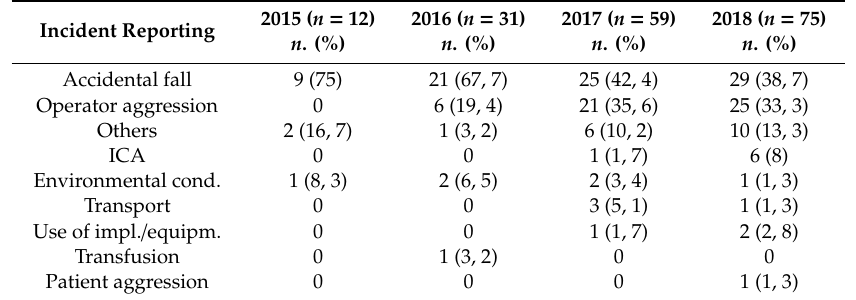
Table 2. Distribution (%) of Incident Reporting records motivated as “others”, the reporting